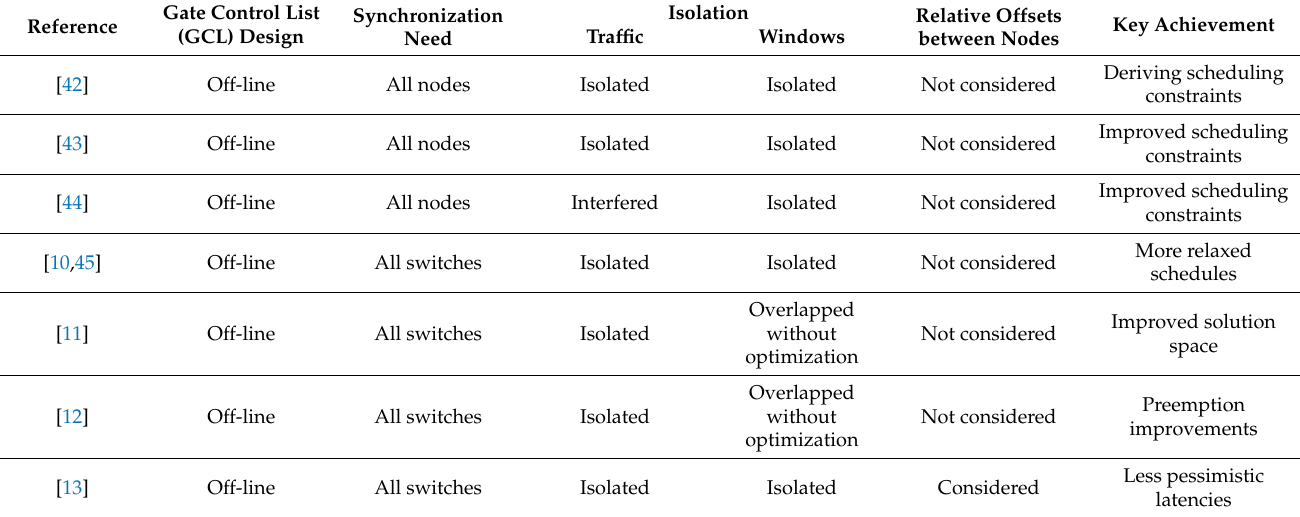
Table 1. Design-based differentiation between relevant studies with associated